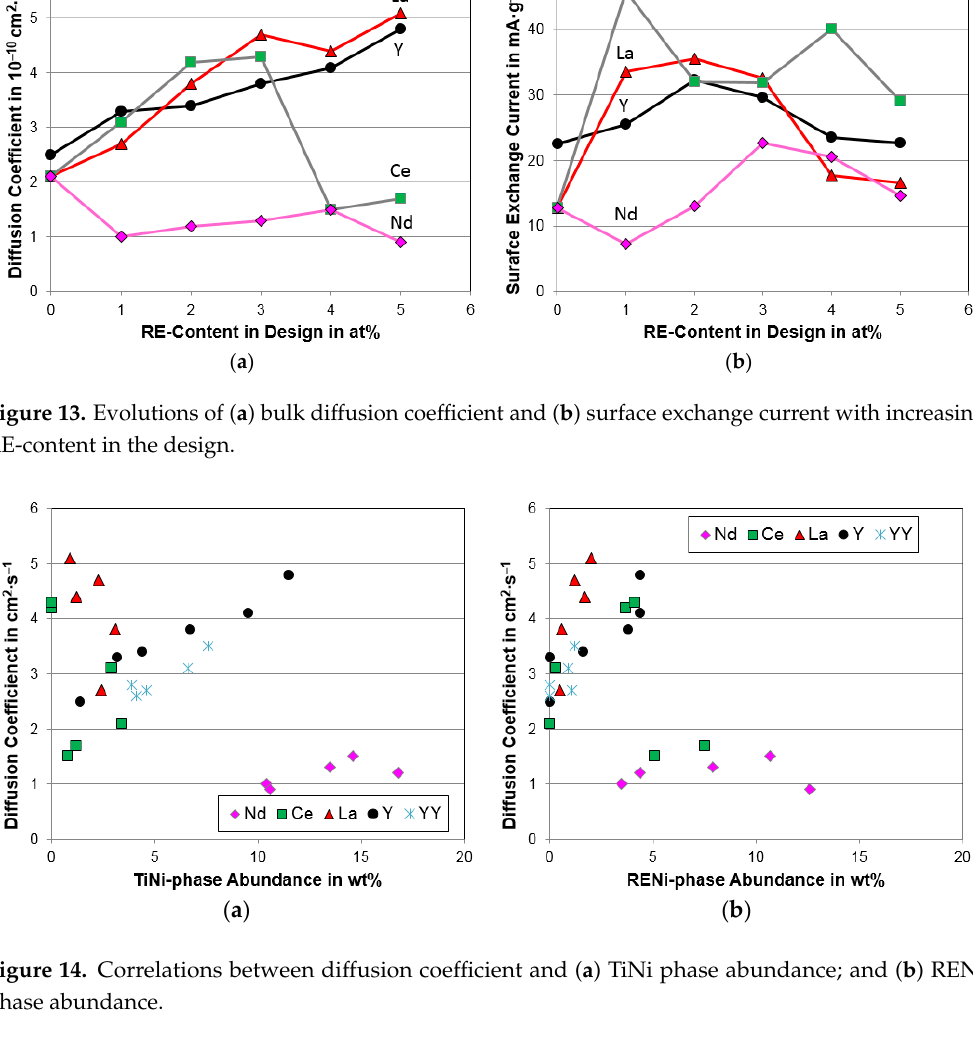
Figure 12. Comparisons of the electrochemical discharge capacities and gaseous phase H ‐ storages of the RE ‐ containing MH alloys by plotting: ( a ) low ‐ rate discharge capacity vs. maximum H ‐ storage capacity; and ( b ) high ‐ rate discharge capacity vs. reversible H ‐ storage capacity. Data set YY is from a